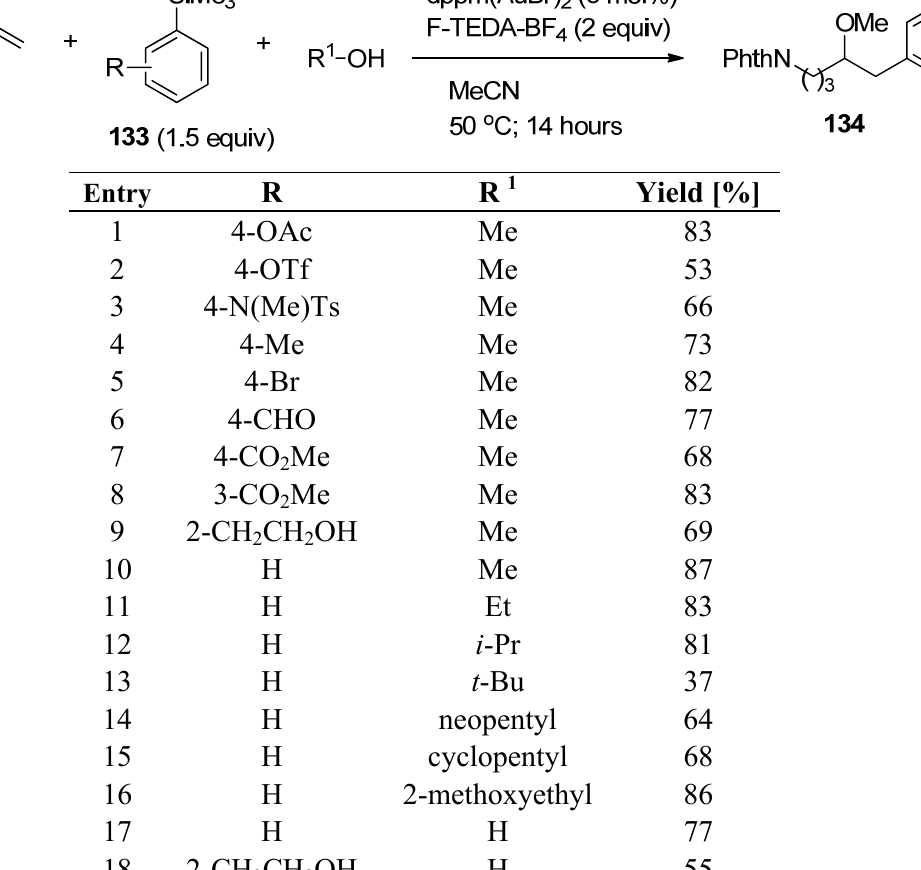
Table 12. Gold-catalyzed and F-TEDA-BF C-C double